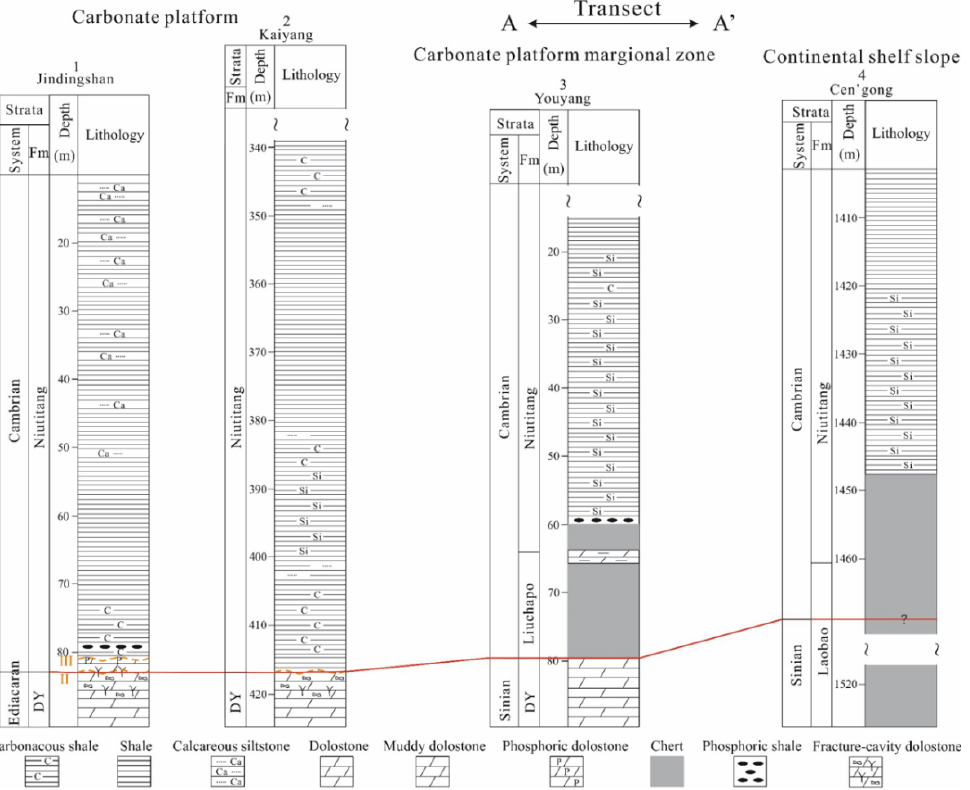
Figure 2. Stratigraphic framework for the lower Cambrian strata of the northern Guizhou Area. Notably, lithology changes in the vertical direction of the Jindingshan, Kaiyang, Youyang and Cen’gong sections. The red line represents the boundary between Cambrian and Precambrian. The orange line represents the unconformities. II: The second episode of Tongwan movement; III: The third episode of Tongwan movement. Sources of lithological data: 1 — Jindingshan; 2 — Kaiyang [31]; 3 — Youyang [22,32]; and 4 —Cen’gong [13,33]. DY = Dengying, Fm = Formation.